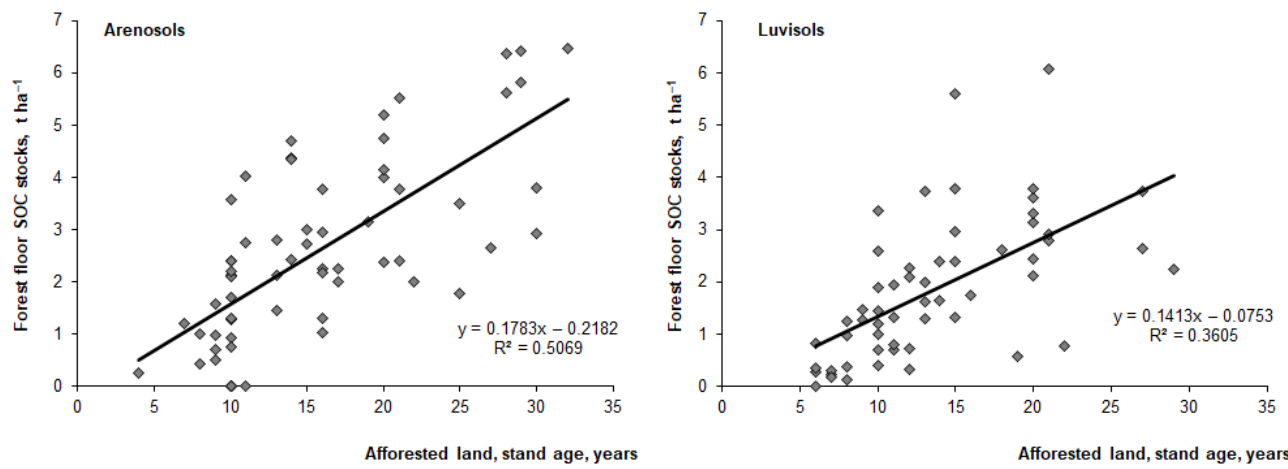
Figure 2. Mean soil organic carbon (SOC) stock in the forest floor of Arenosols and Luvisols in relation to the stand age in